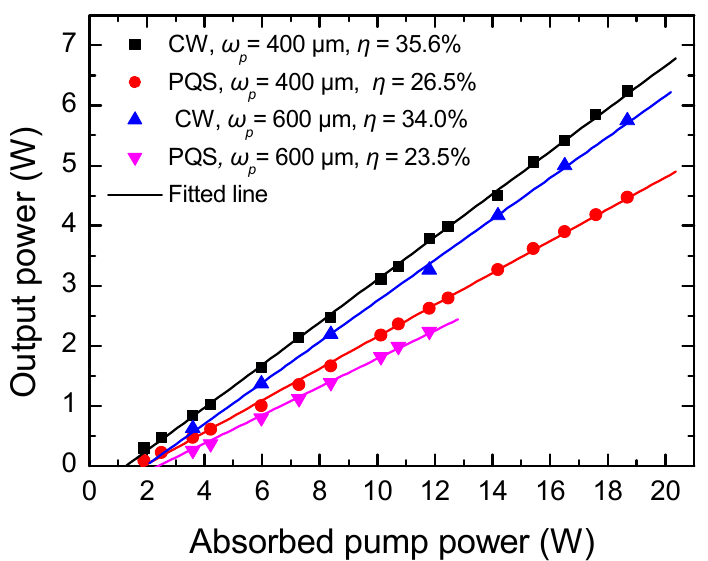
Figure 5. Output power vs. absorbed pump power ( T oc = 0.25).